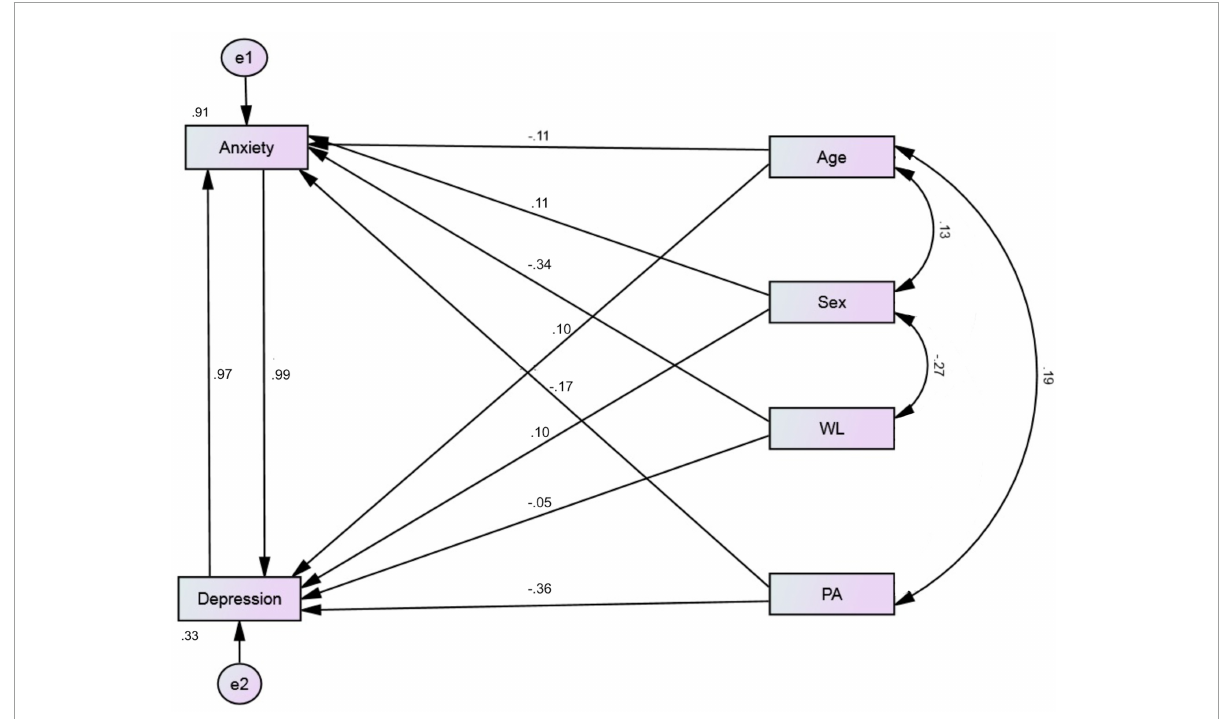
FIGURE2 Structural equation path model predicting anxiety and depression in ED